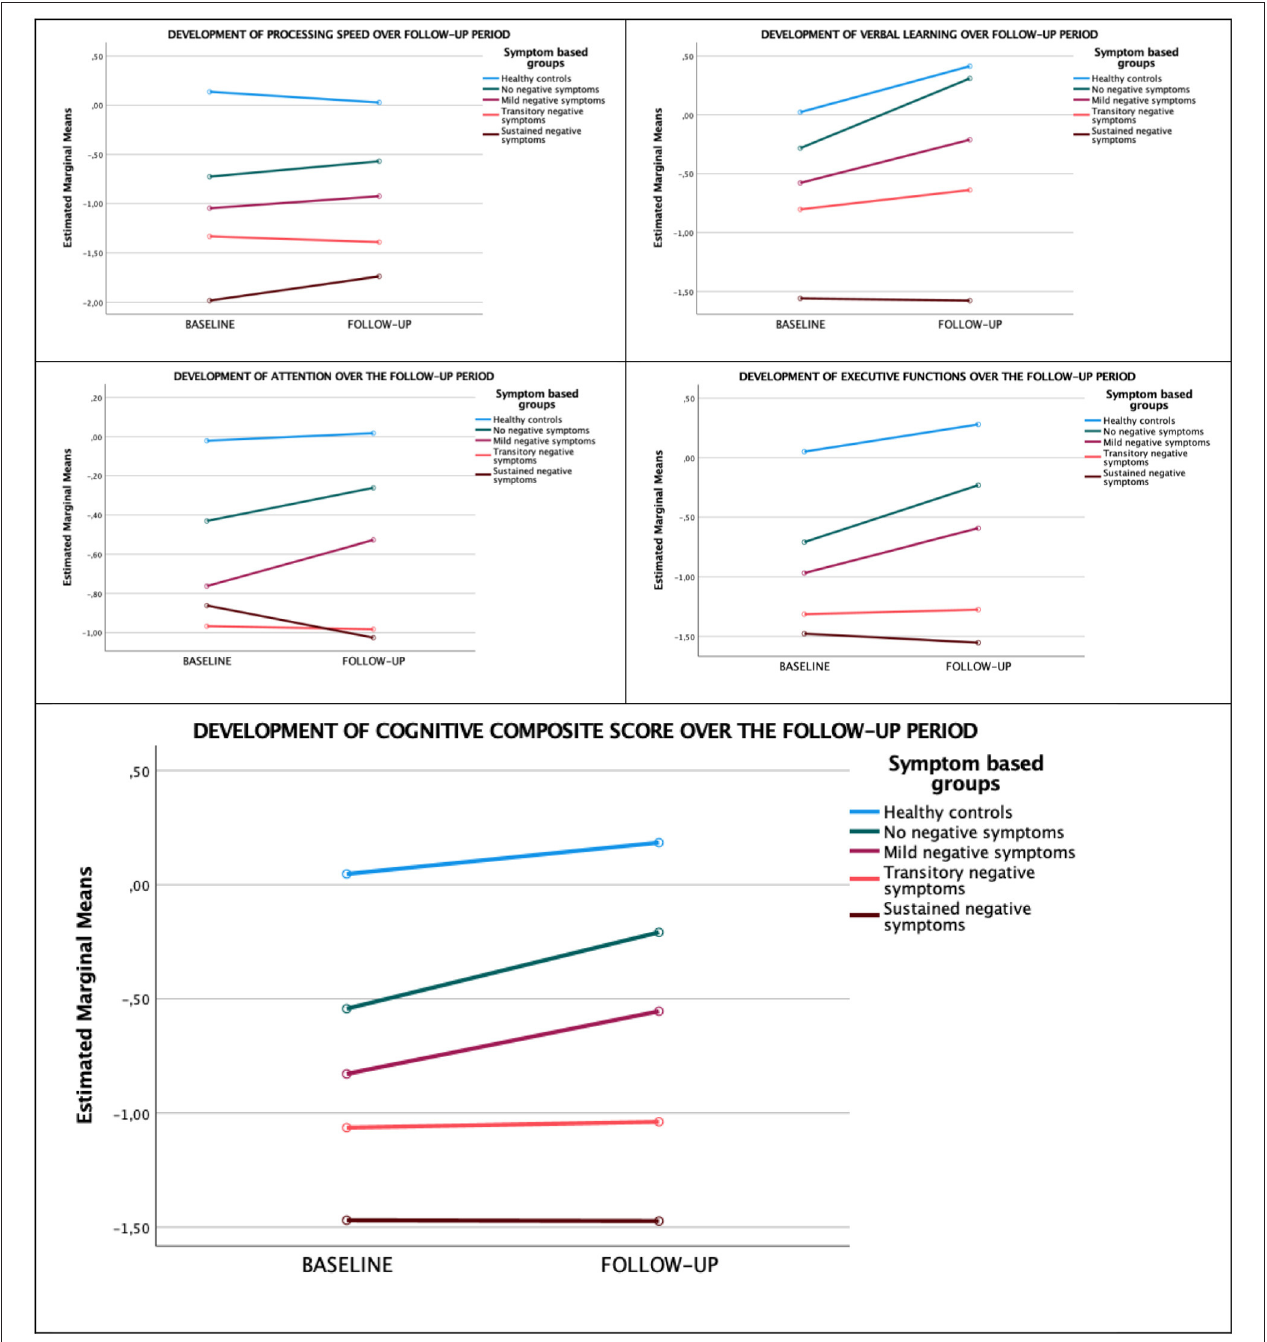
FIGURE 3 | Development of cognitive domains over the 10-year follow-up.